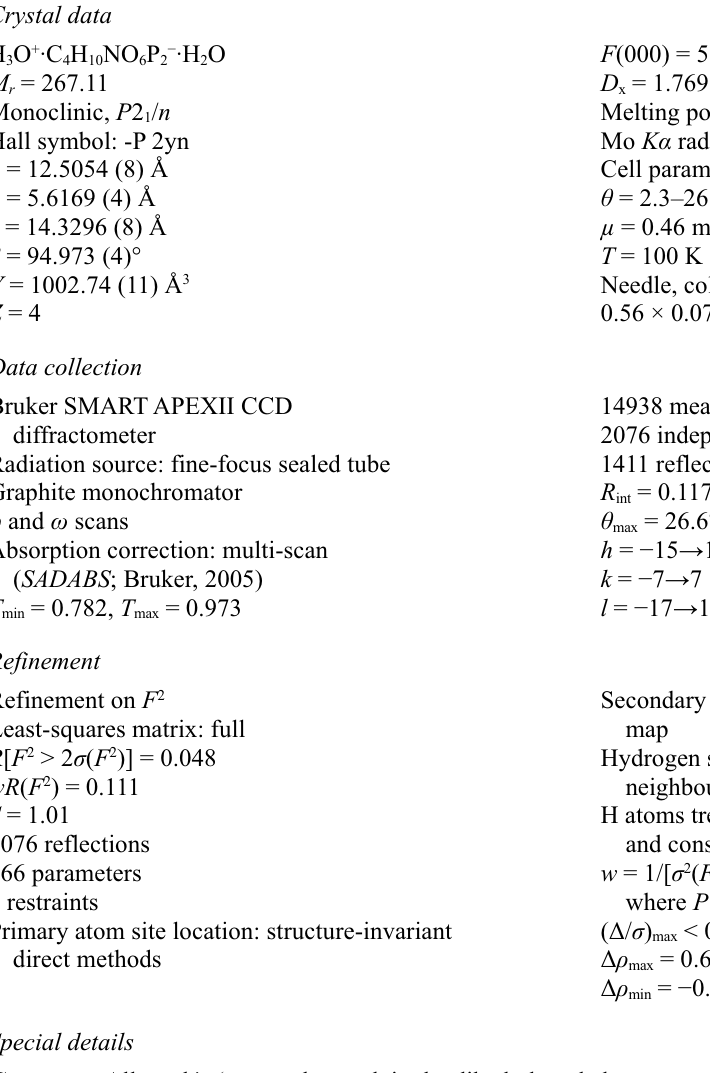
Figure 2 Crystal packing of title compound, projection along b axis. Dashed lines indicate hydrogen